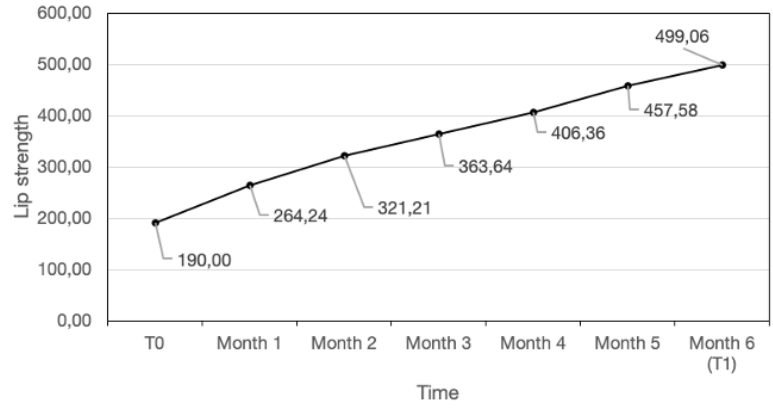
Figure 6. Lip strength (measured in centiNewton) over the study period in compliant subjects.